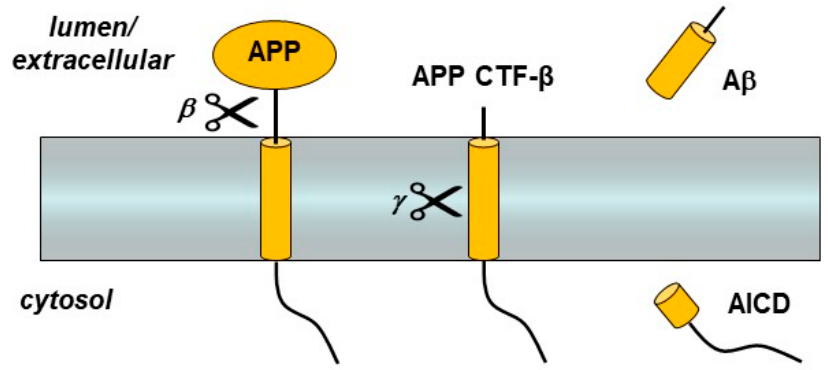
Figure 1. Amyloid precursor protein (APP) processing by β - and γ -secretases. The single-pass membrane protein APP is proteolyzed just outside the transmembrane domain (TMD) by β -secre- tase. The remaining membrane-bound C-terminal fragment (APP CTF- β ) is then cleaved within the TMD to produce the amyloid β -peptide (A β ) and the APP intracellular domain